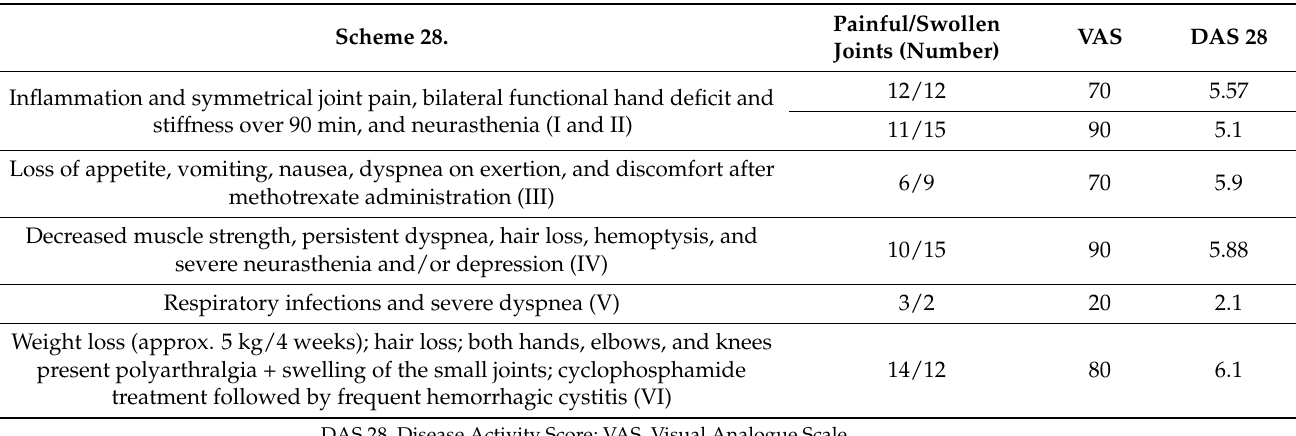
Table 1. The patient’s clinical evaluation during the disease course. Scheme 28.